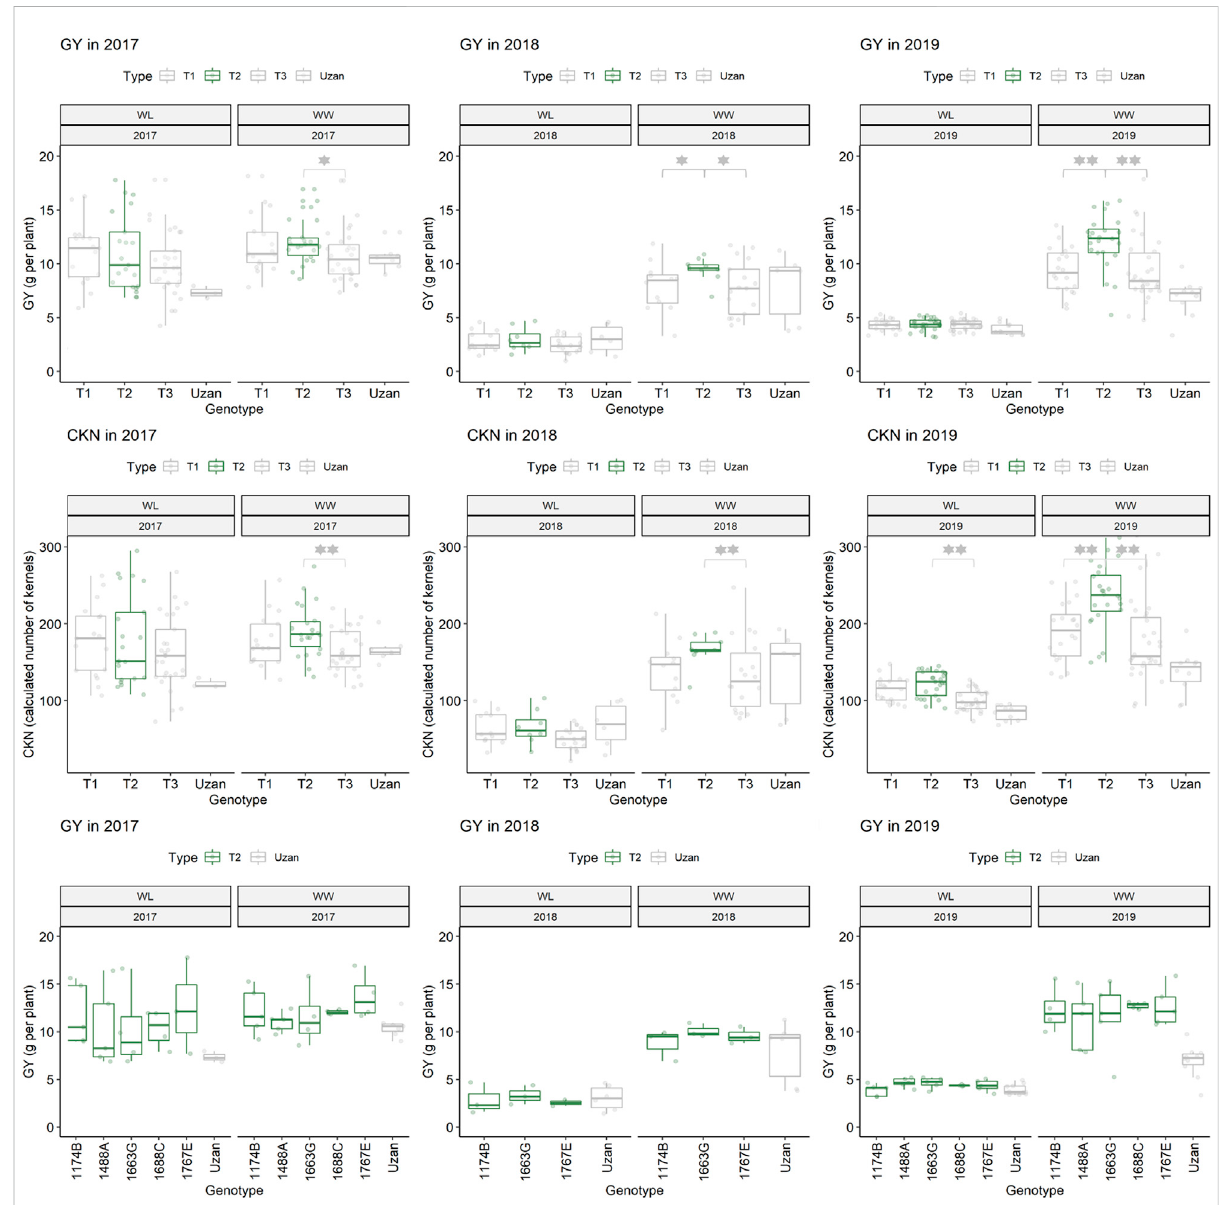
FIGURE 6 Grain yield (GY) and calculated kernel number (CKN) of segmental sub-NILs, carrying different alleles of the iSelect marker Tdurum_contig27976_414 and Gene-1741_103. T1: sub-NILs with the wild emmer allele from Tdurum_contig27976_414 and Gene-1741_103. T2 (green): sub-NILs with the wild emmer allele of Tdurum_contig27976_414 and elite parent allele of Gene-1741_103. T3: sub-NILs with the elite parentalleleofTdurum_contig27976_414andGene-1741_103.Uzanisthenameoftherespectiveeliteparent.FigureCshowstheGYvaluesof each of the sub-NIL that belongs to T2. Signi fi csant differences between the T1, T2, and T3 groups of genotypes were calculated with a two-sided t -test. p -values ≤ 0.05 or 0.01 were marked with one or two stars,